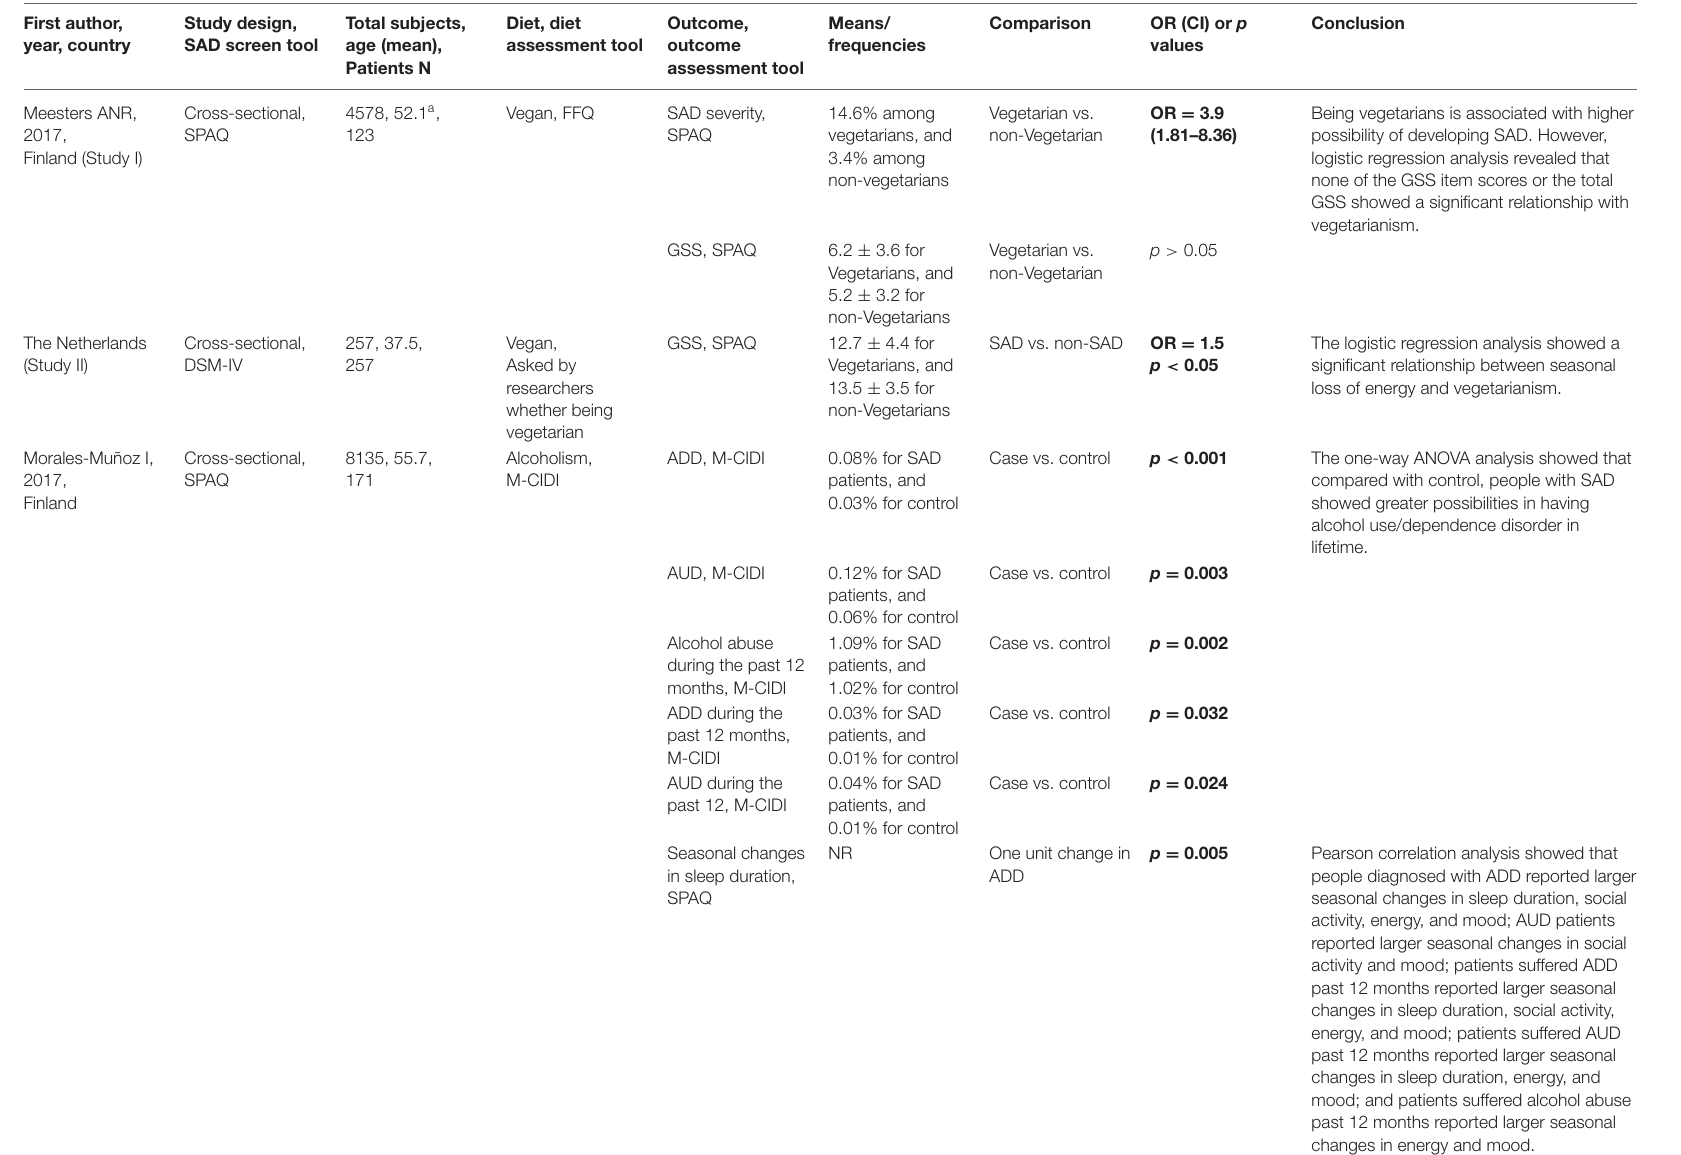
TABLE 1 | Characteristics of included studies evaluating the associations between diet and